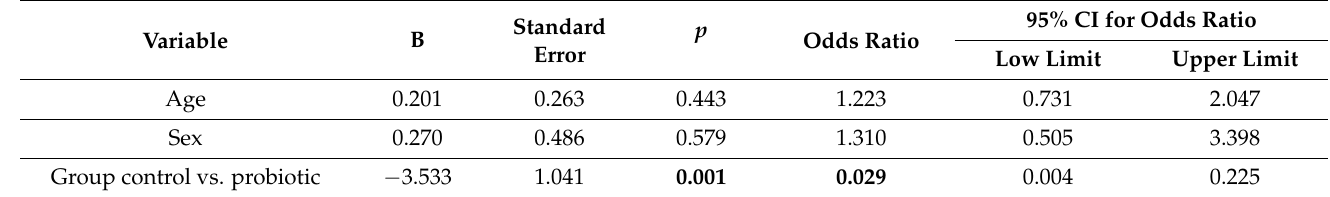
Table 5. Multivariate analysis of ∆ ICDAS 4–6 > 0; 12 months—baseline, n (%).